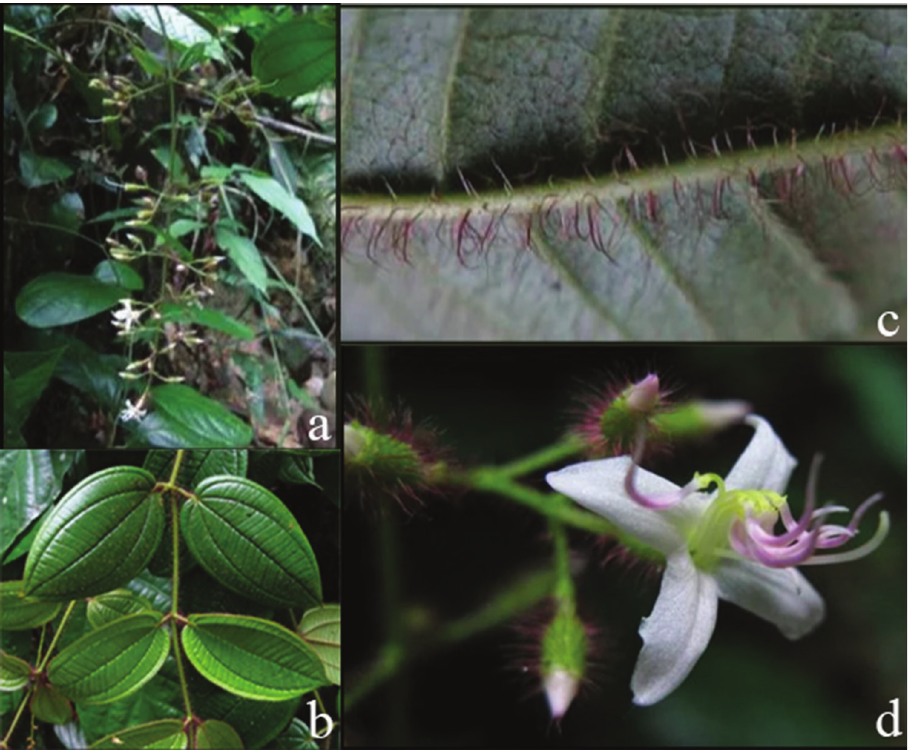
Figure 17. Dissochaeta hirsutoidea a habit b branchlet c abaxial midrib d hypanthium and flower. Pho- tographs by J.